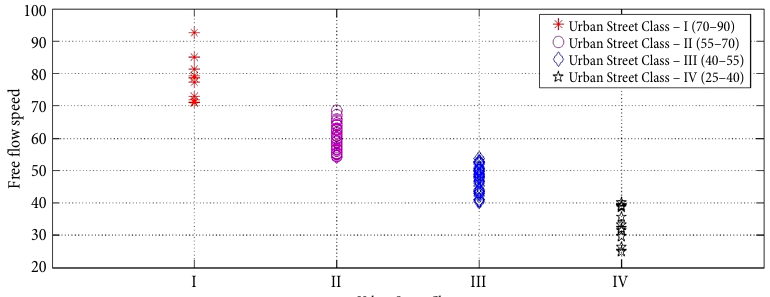
Fig. 4. AP clustering of FFS for urban street